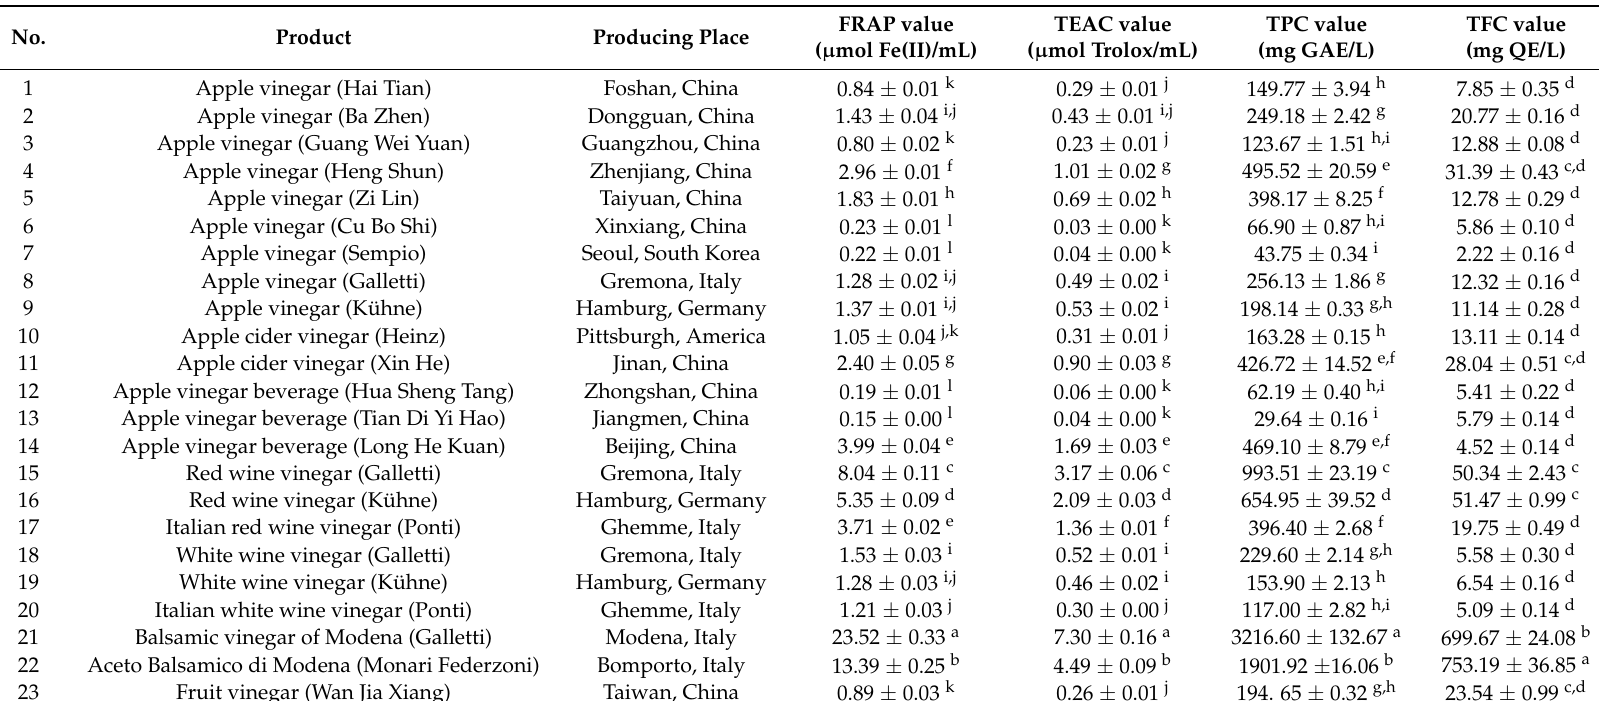
Table 1. The ferric-reducing antioxidant power (FRAP), Trolox equivalent antioxidant capacity (TEAC), total phenolic contents (TPC), and total flavonoid contents (TFC) values of 23 fruit